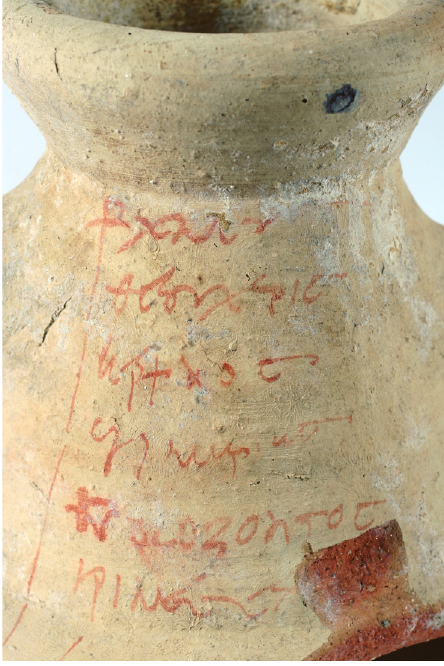
Figure 6. The six-line dipinto